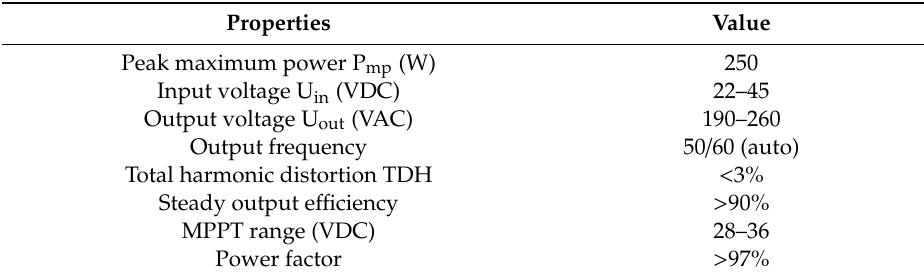
Table 2. Parameters of